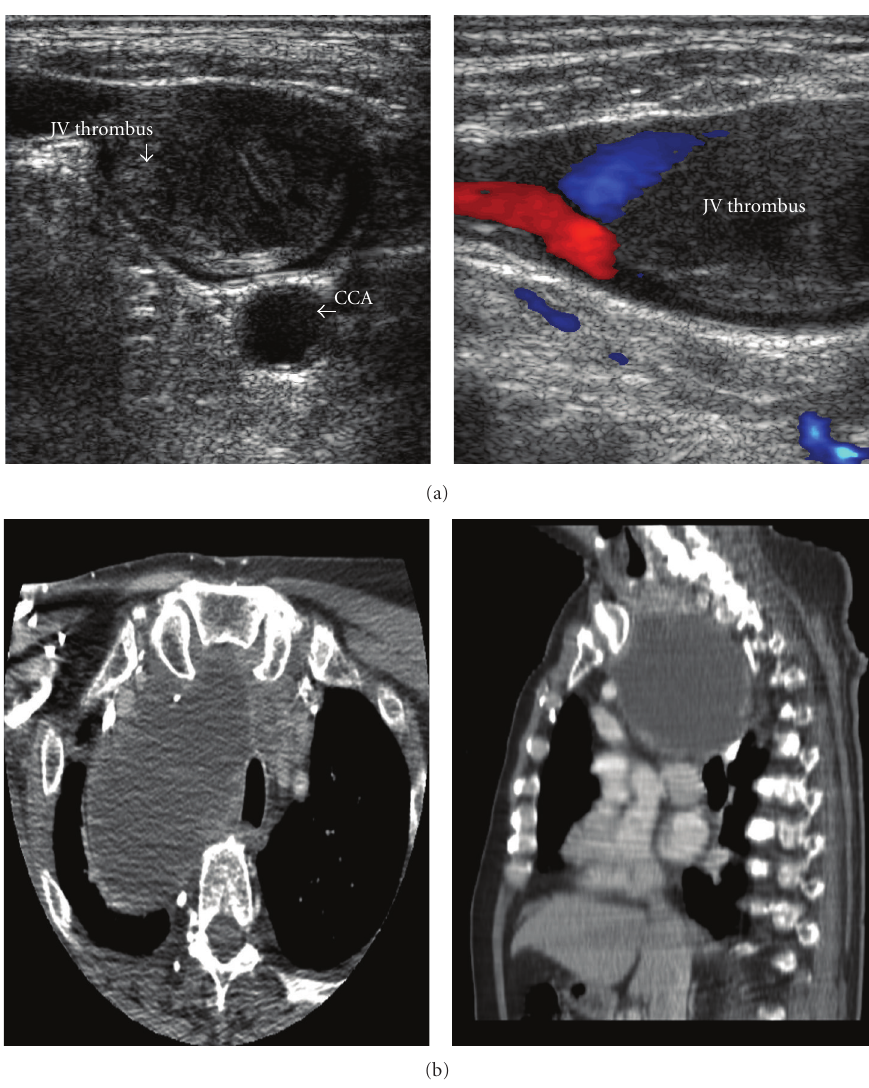
cord function. Screening for hematologic and